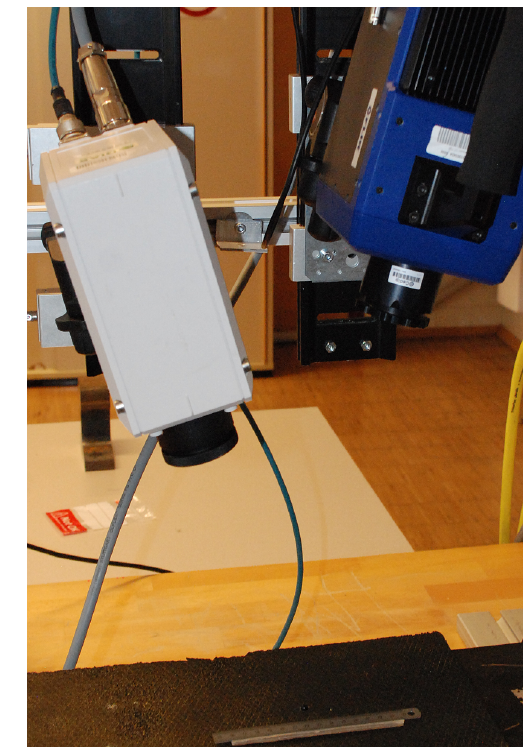
Figure 1. Experimental setup in the laboratory with a mi- crobolometer and with a cooled photon detector, recording objects in motion on the conveyor belt.